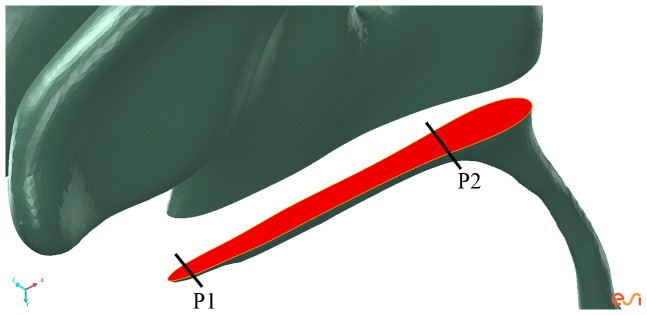
A segment of the lower region third ventricle used to obtain CSF velocity and pressure.The lower region of the third ventricle used to evaluate range of CSF velocity and pressure before and after ETV. The range was taken between points P1 and P2.